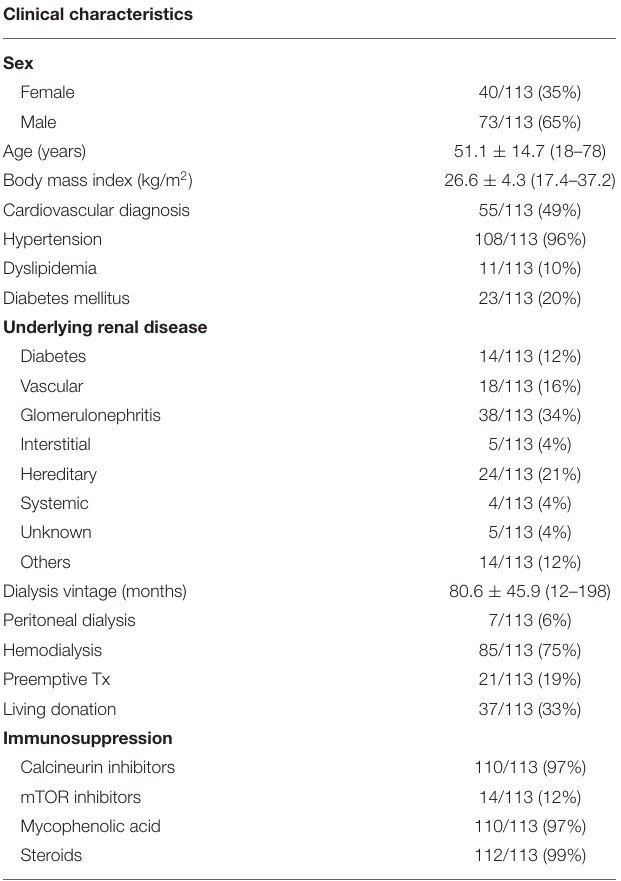
TABLE 1 | Clinical characteristics of the study cohort ( n = 113) at the time of transplantation. Clinical characteristics